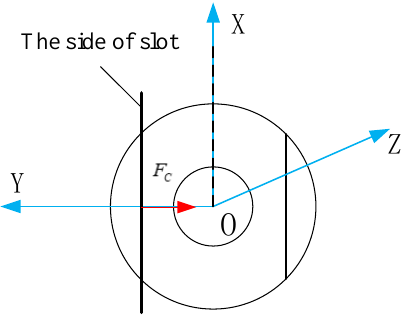
Figure 7. The key in stable state with external force.